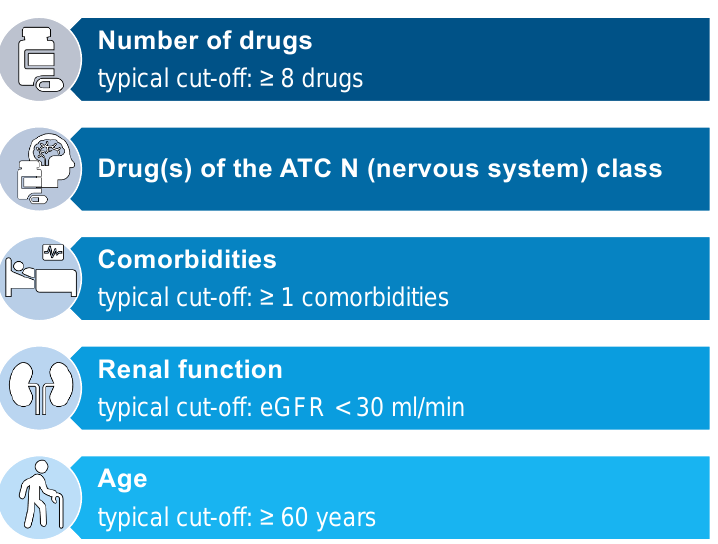
Figure 13. Five most frequently investigated risk factors and their respective typical cut-off values.